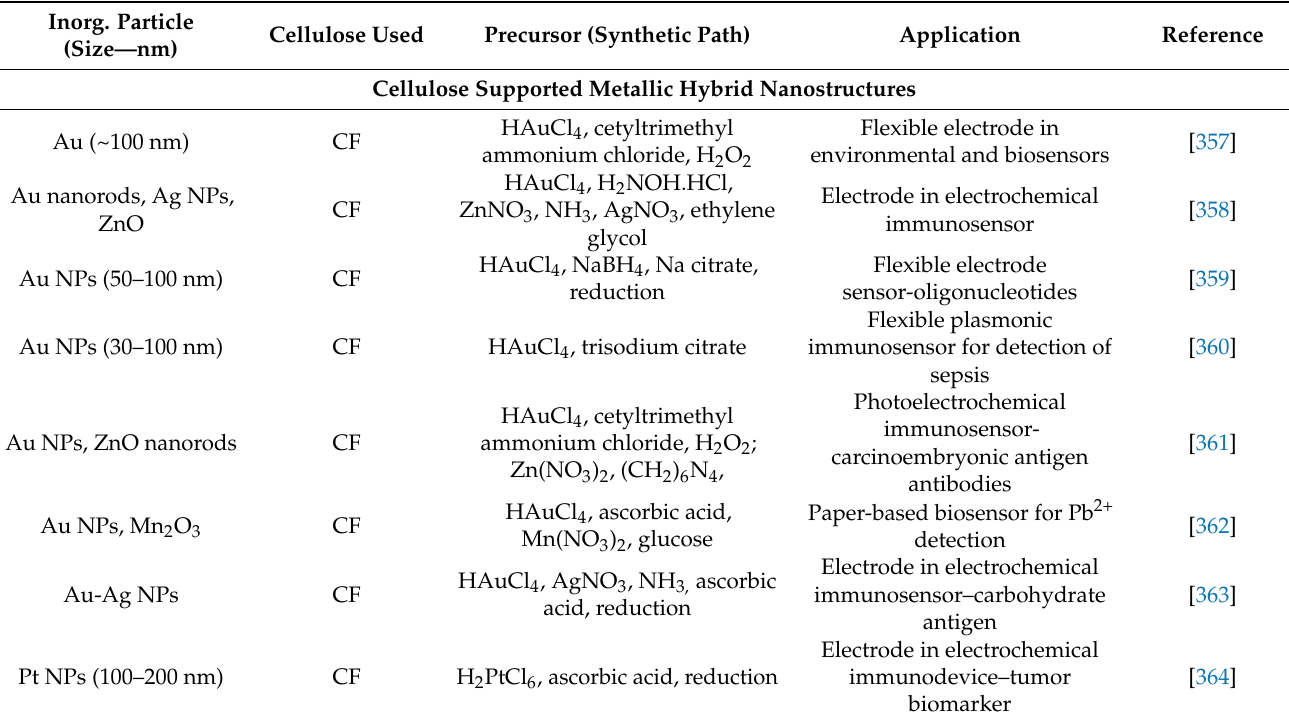
Table 6. The list of publications on cellulose supported/templated inorganic hybrid nanostructures. The list is organized from large cellulose structures (CF and RC) via the microstructured celluloses (MCC and MFC) to nanostructured celluloses (BNC and CNCs). Inorg.